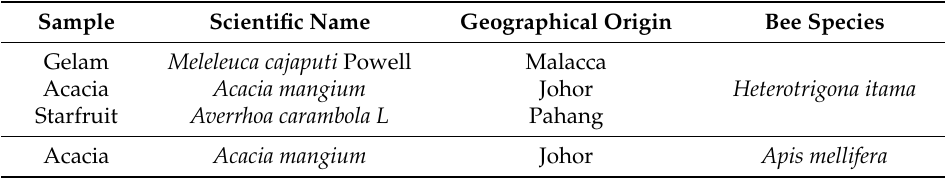
Table 6. Stingless bee honey samples from varying botanical